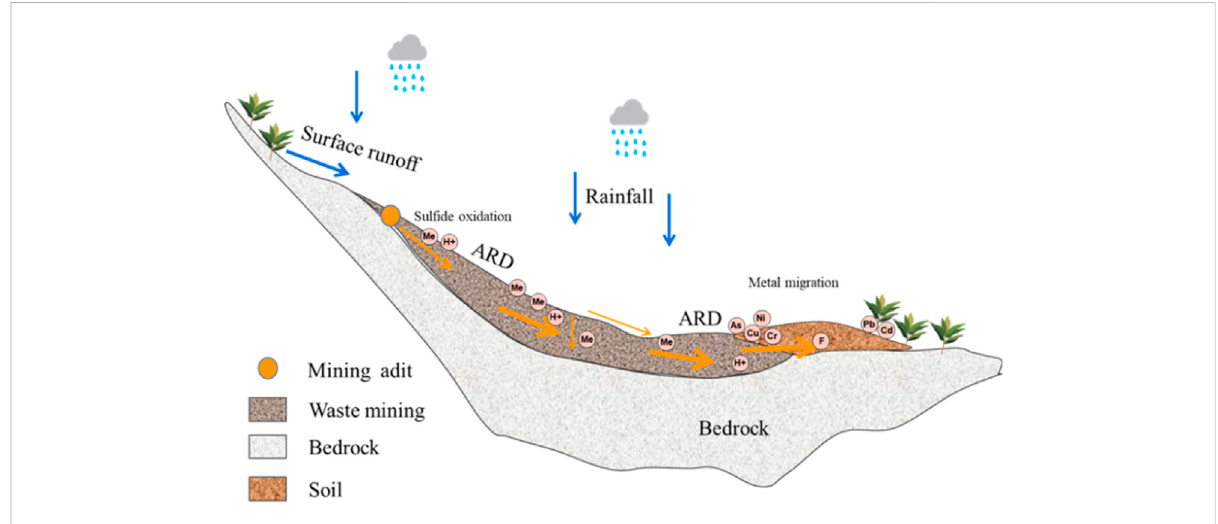
FIGURE 10 Conceptual site model in the abandoned pyrite mining